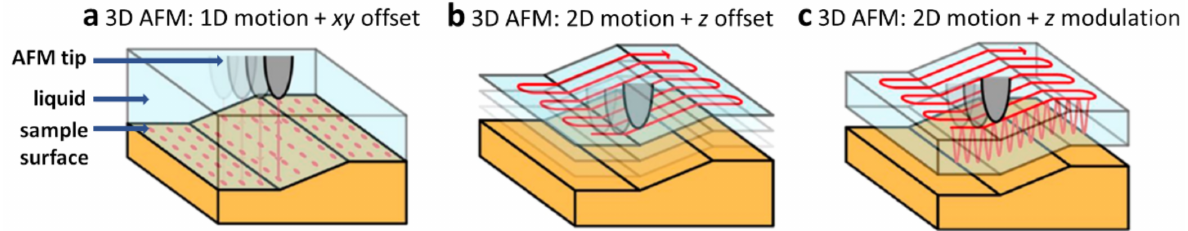
Figure 2. The concepts of scanner movement in 3D AFM imaging: ( a ) scanner is moving in a 1D motion with xy offset, ( b ) scanner moves at a xy plane and a given z offset, ( c ) scanner moves at a fast sinusoidal motion in xy direction with simultaneous modulation of z position. Reproduced with permission from Fukuma, T.; ACS Nano ; published by ACS Publications,